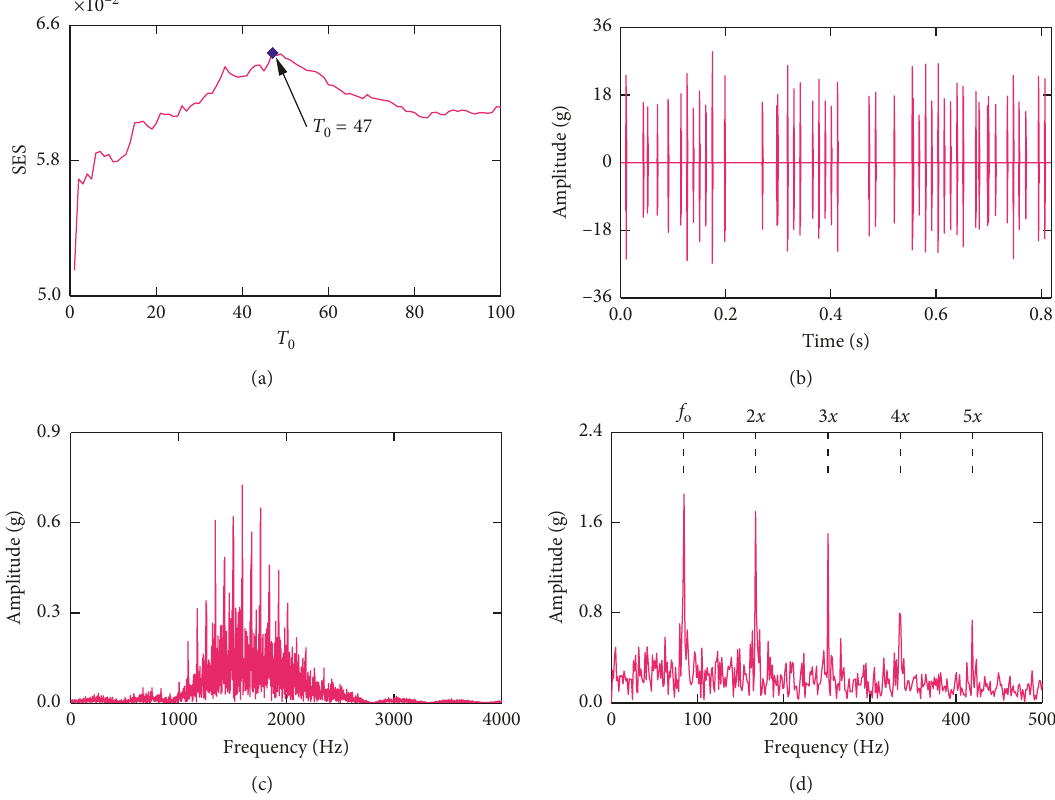
Figure 14: Separated impulsive components for the outer race fault using the proposed method: (a) SES values for the different number of iterations; (b) separated impulse signal for the outer race fault; (c) Fourier spectrum of (b); (d) Hilbert envelope spectrum of